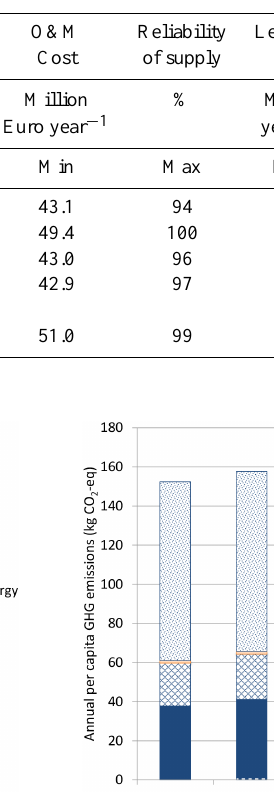
Table 2. Evaluation of intervention strategies.